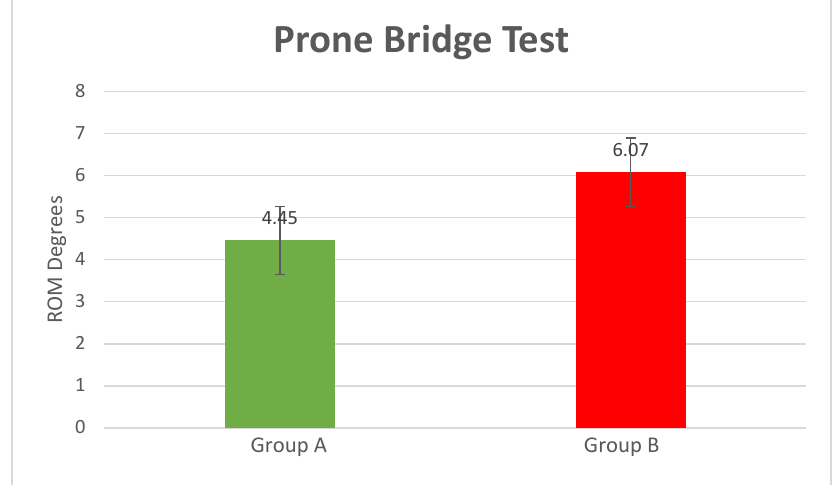
Figure 5. Prone bridge test results ( p -value = 0.0001) . Left-Side Bridge Test The position obtained during the execution of the left-side bridge test was right lateral flexion (compared to the neutral position), with patients achieving the following values: mean = 2.72° of right lateral flexion SD = 1.10 for Group A and mean = 3.64° of right lateral flexion SD = 1.09 for Group B ( p -value = 0.0004) (Figure 6).